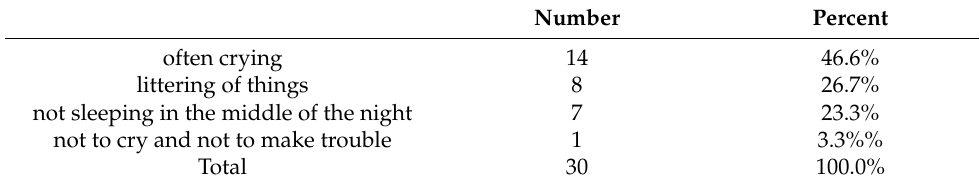
Table 1. The top four parenting troubles. Number Percent often crying 14 46.6% littering of things 8 26.7% not sleeping in the middle of the night 7 23.3% not to cry and not to make trouble 1 3.3%% Total 30 100.0%